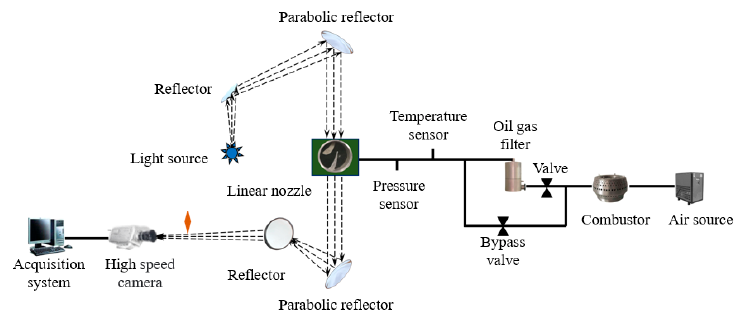
Figure 15. Schematic of the shock test.